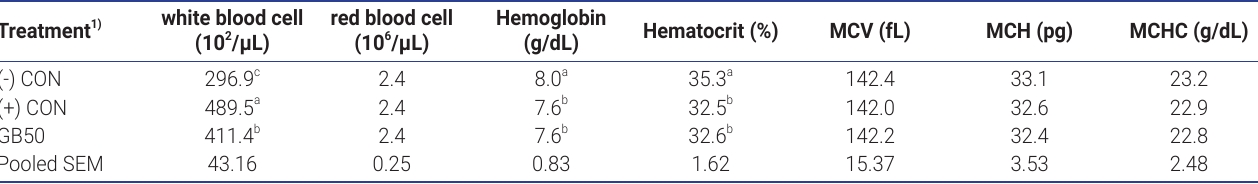
Table 4. Effects of heat stress on blood cell count (Trial 2) Treatment